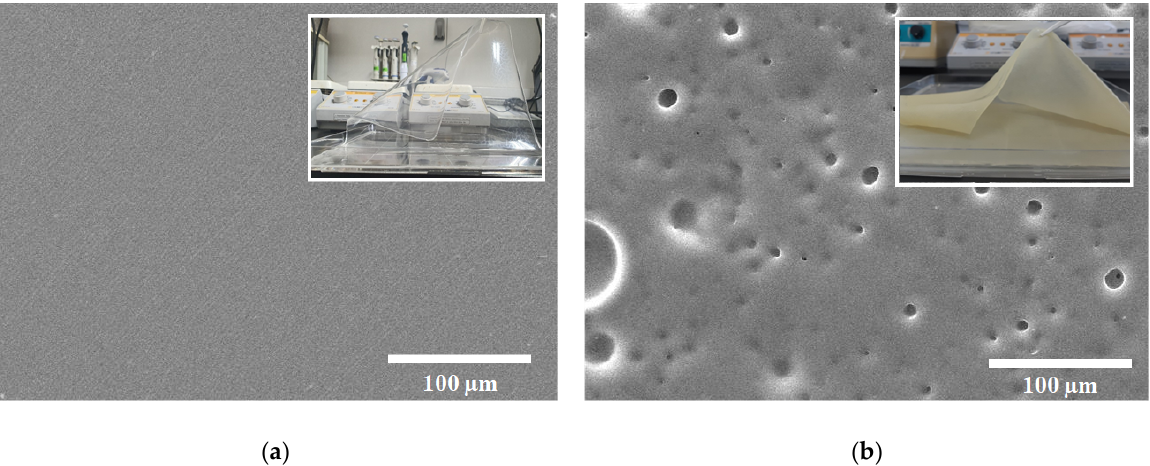
Figure 5. SEM images of B–MPE 0% ( a ) and B–MPE 15% ( b ) (inset: film-type product).